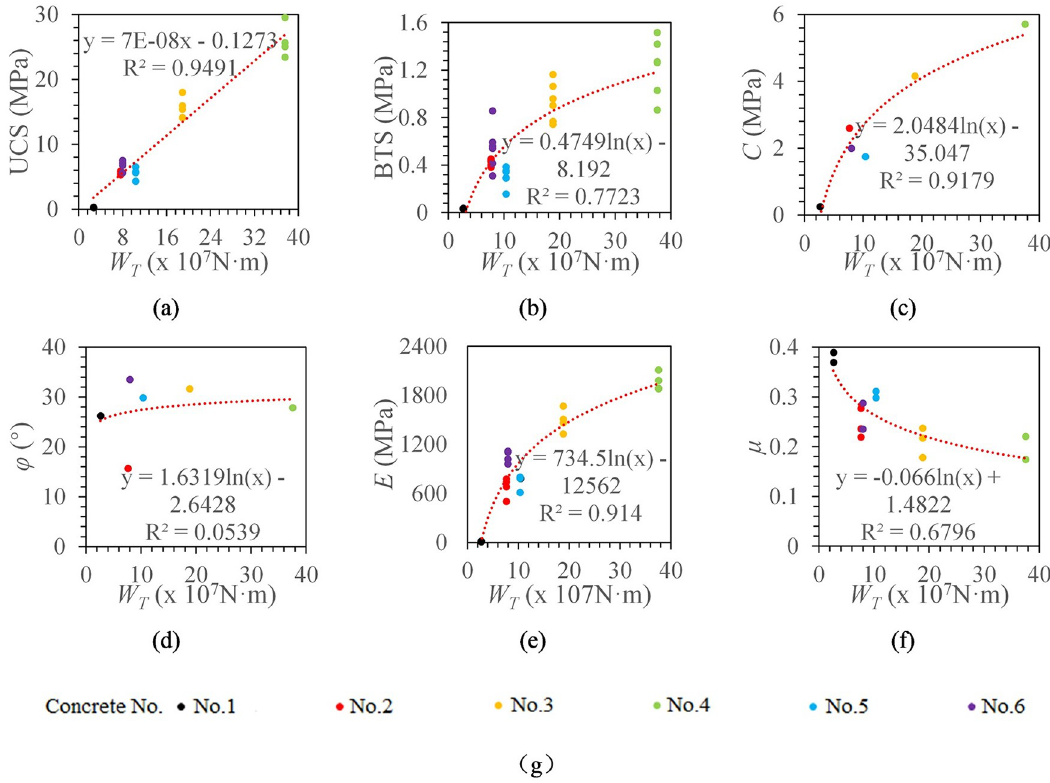
Fig 13. The relationship between torque work and concrete mechanical properties. (a) The relationship between W (b) The relationship between W relationship between W T and E . (f) The relationship between W T and μ . (g)